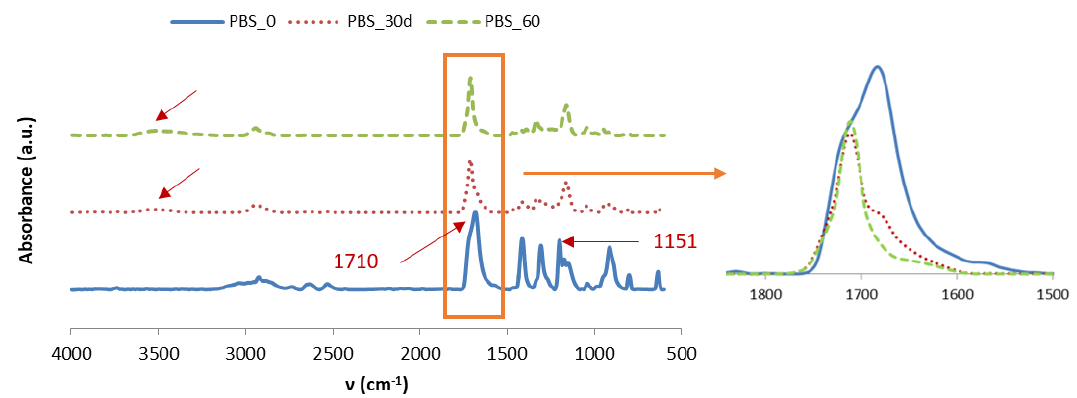
Figure 12. FTIR spectra for PBS before and after aging